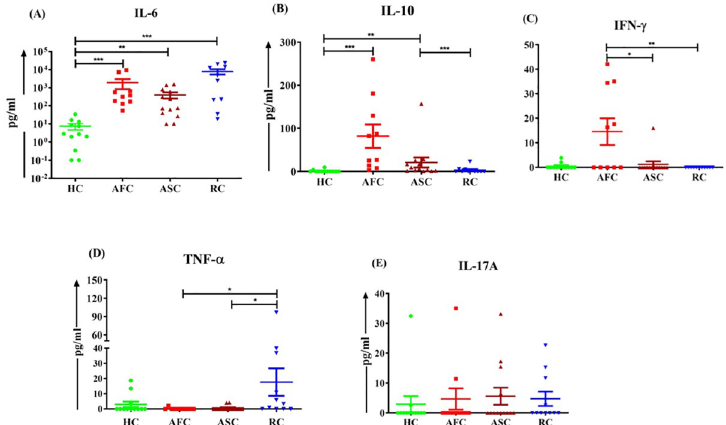
Fig 4. Level of Th1/Th2/Th17 cytokines in the serum samples of acute phase of infection in fatal cases (AFC) (n = 10), acute phase of infection in survived cases (ASC) (n = 13), recovered cases (RC) (n = 11) and healthy controls (HC) (n = 12) were determined using cytometric bead array (CBA) assay. The results are expressed in scatter dot plot of individual values and data are given as Mean ± SEM (pg/ml) of (A) IL-6, (B) IL-10, (C) IFN- γ , (D) TNF- α and (E) IL-17A. Data were analyzed between groups by the non-parametric Kruskal–Wallis test followed by the post-hoc Dunn’s multiple comparison test. The horizontal lines indicate mean values. � P < 0.05; �� P < 0.01; ��� P <